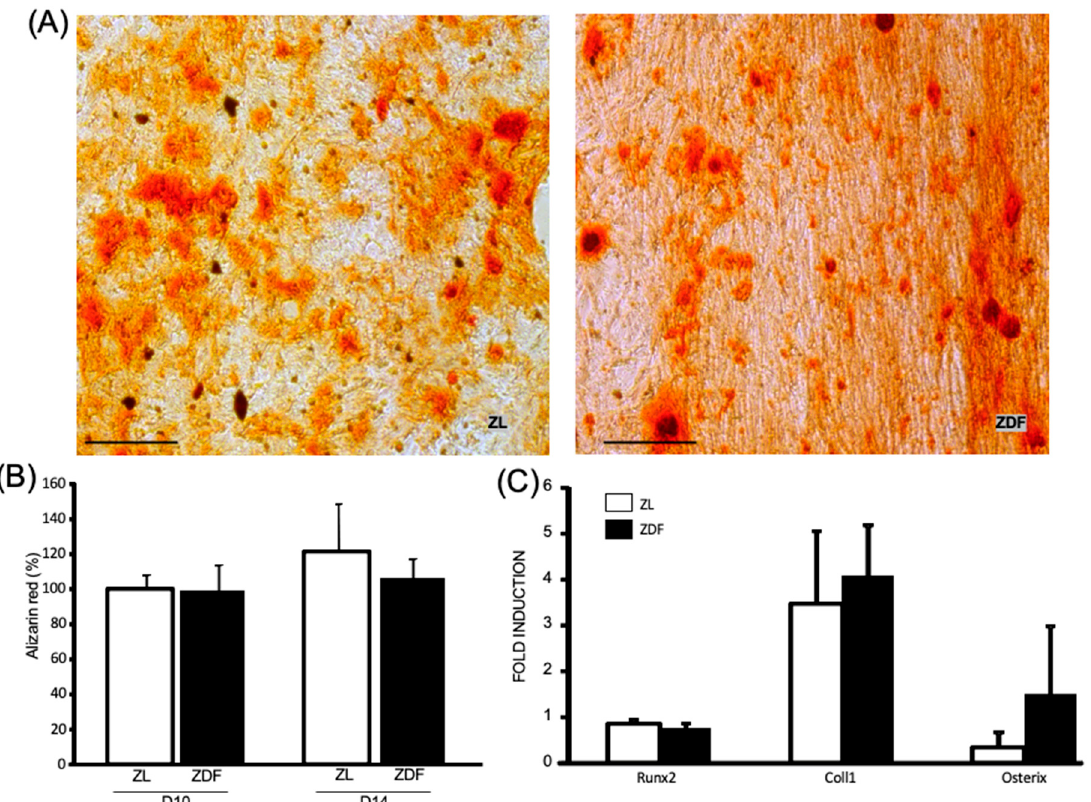
Figure 4. Osteogenic differentiation of ZDF- and ZL-BMMSCs. BMMSCs from ZDF and ZL rats were submitted to an osteogenic induction medium. ( A ) Photograph of Alizarin red staining after 21 days of culture in osteogenic medium, ( B ) Dosage of alizarin red staining by spectrophotometry, Scale bar = 200 μ m. ( C ) Expression levels of the Runx2, CollI, and Osterix genes in the BMMSCs measured by qPCR at day 14. Values are mean ± SEM, calculated from 3 independent wells per condition in 3 independent experiments (n = 9)